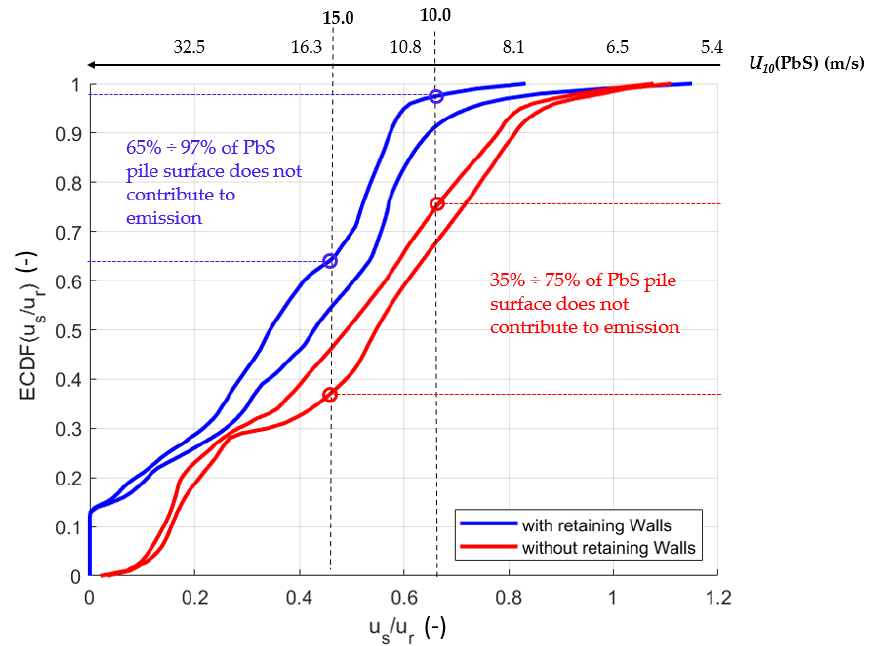
Figure 10. Envelopes of empirical cumulative distribution function of u s /u r ratio for a high-square Lead Glance stockpile, with and without enclosing walls (respectively blue and red lines), for incoming SE wind (135° ± 15°).